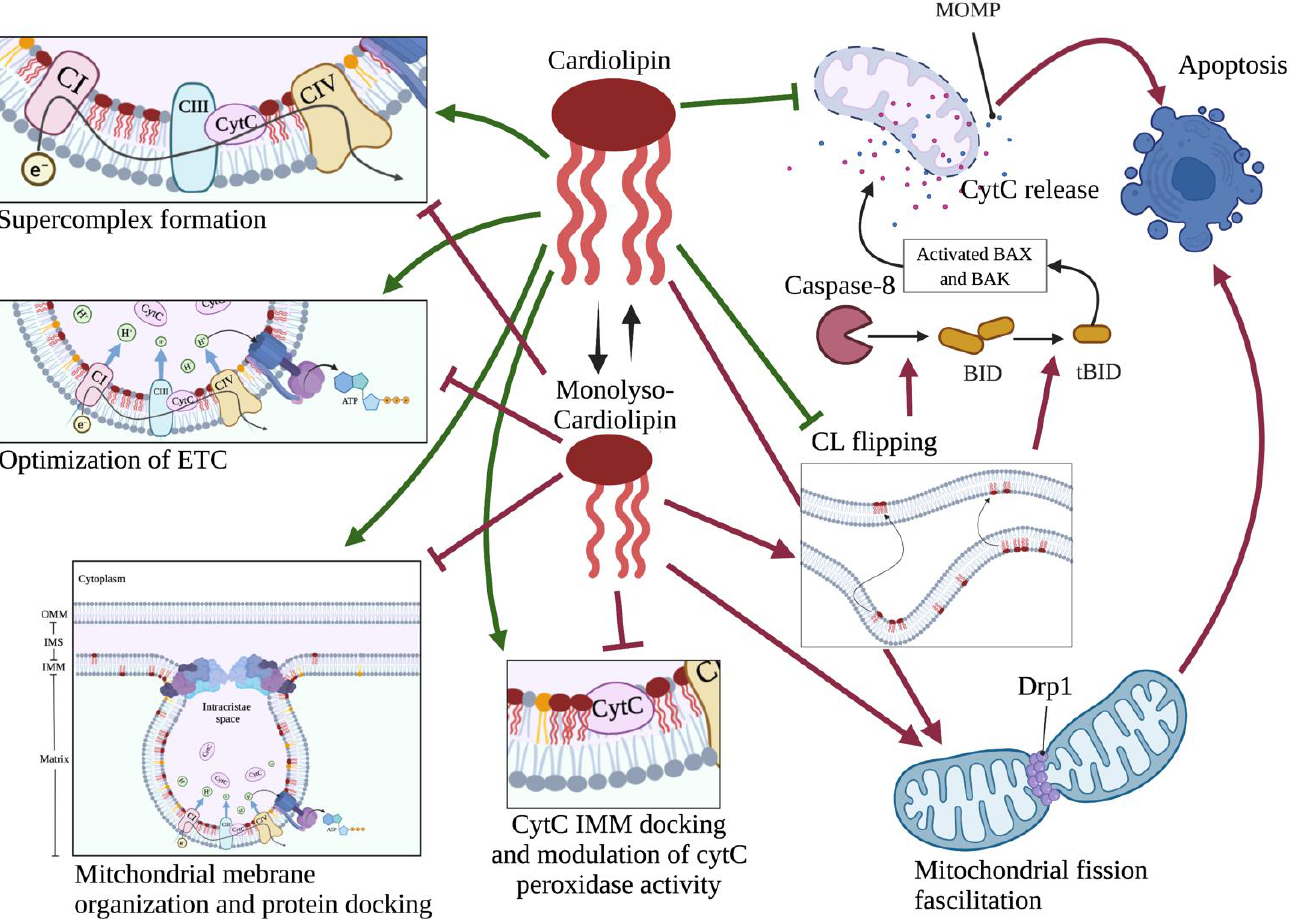
Figure 5. Effects of cardiolipin (CL) on physiology and apoptosis. Emphasis is given on CL’s unique ability to directly bind and anchor proteins and CytC on IMM. Formation of monolyso-CL leads to loss of all physiologic abilities of mature CL, flipping to the OMM from the IMM where CL is normally confined and facilitation of apoptosis in a Bid-mediated manner. Of note, loss of mature CL from the IMM disturbs electron transport, leading to increased ROS formation and ignition of the apoptotic cascade. Besides, mature CL loss allows for the membrane-bound CytC to be released to the IMS and sensitizes to membrane permeability and the cell to apoptosis. Created with BioRender.com, accessed on 20 March